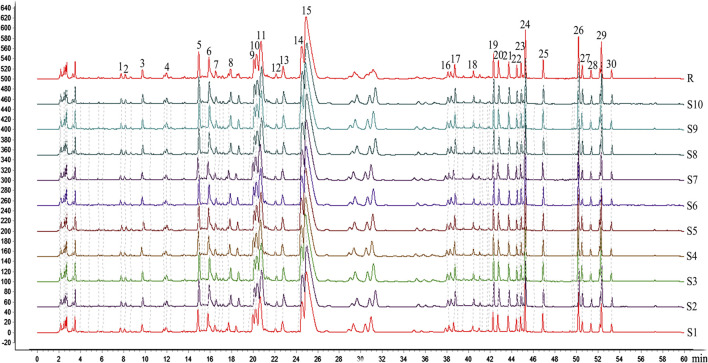
The common pattern diagram of HPLC fingerprint chromatograms of extracts from Gandou Decoction (GDD).